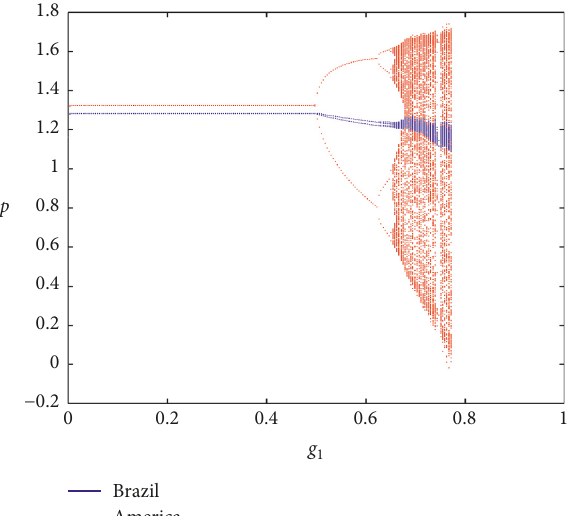
Figure 4: The stable Nash equilibrium price evolves over time diagram.